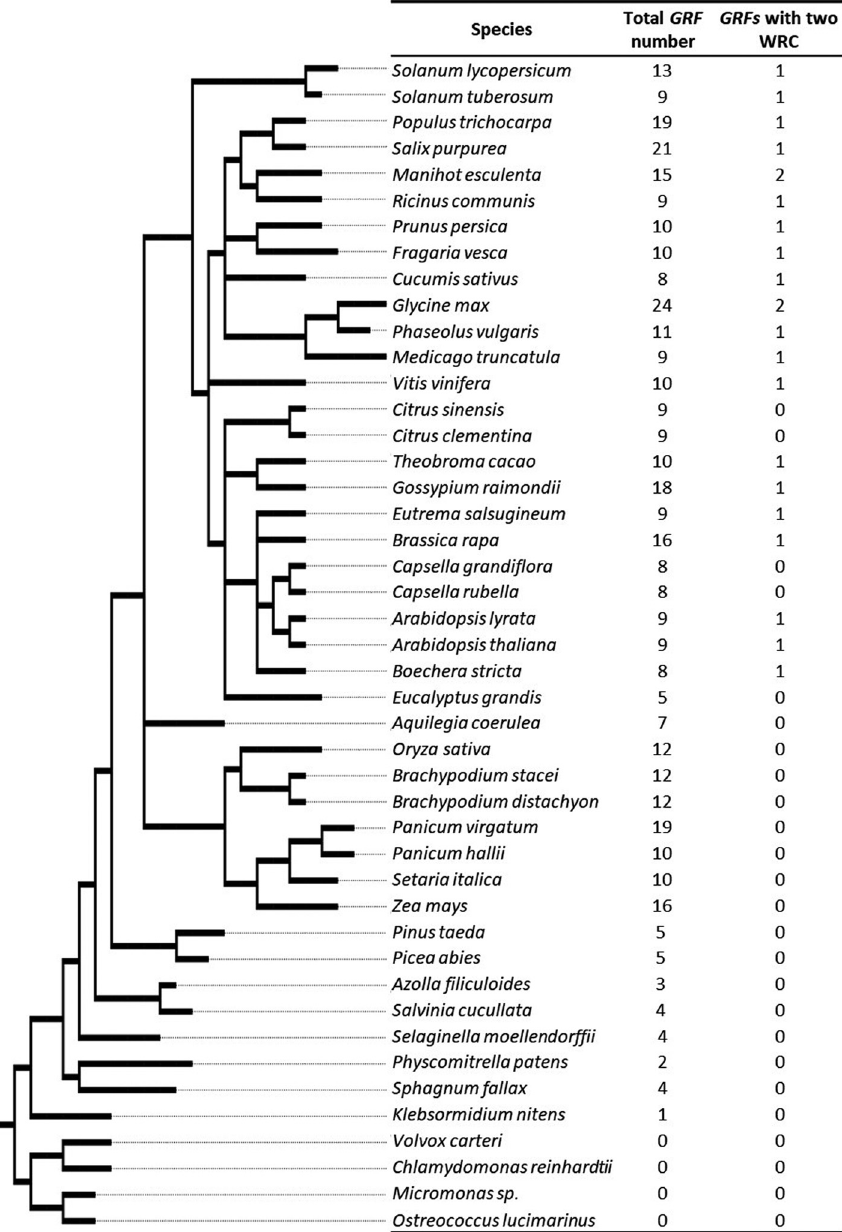
Figure 1 - Tree of species. Species searched and the number of genes found in each species. The tree was based on NCBI Taxonomy and was constructed with phyloT, available at: